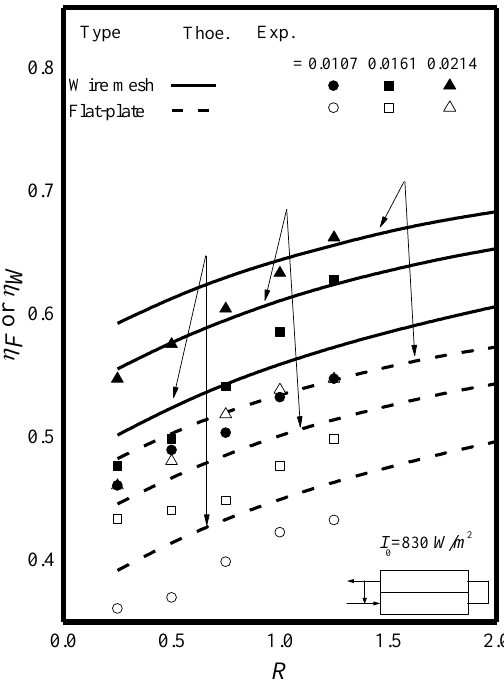
Figure 4. Effect of the recycle ratio on collector efficiency in flat-plate and wire mesh packed solar air heaters with